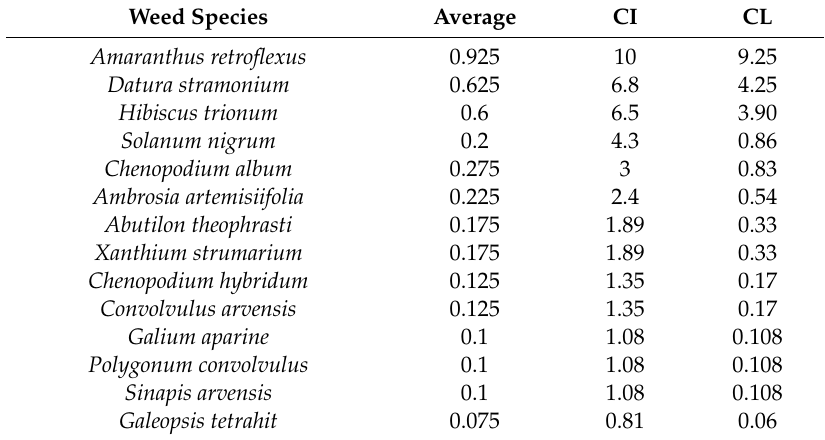
Table 7. Competitive index and competitive load for broadleaf weeds at Pobeda.